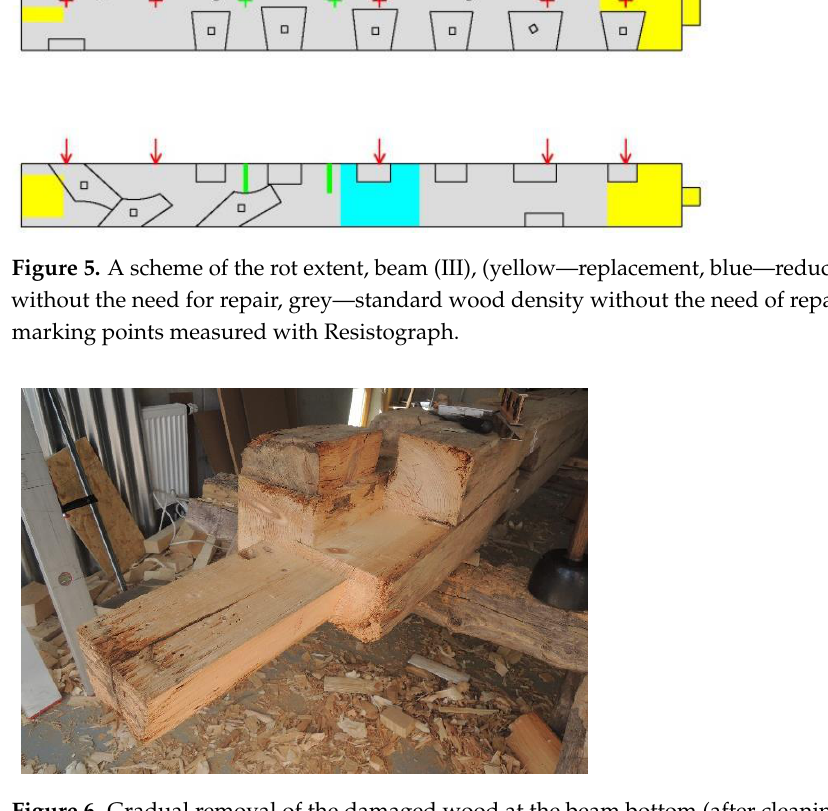
Figure 6. Gradual removal of the damaged wood at the beam bottom (after cleaning).